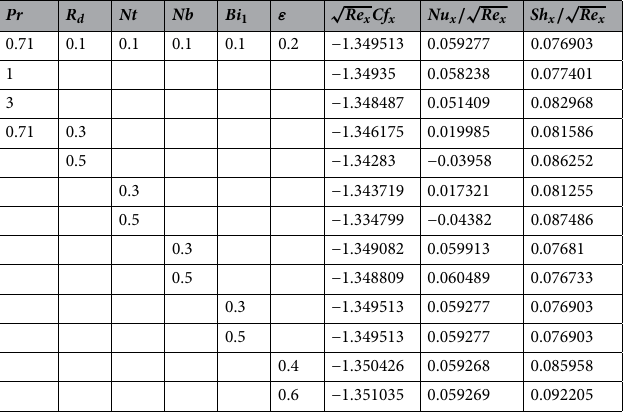
Table 4. The values of √ Re x Cf x , Nu x / √ Re x , and Sh x / √ Re x , for diverse values of Pr , Rd , Nt , Nb , Bi 1 and ε when n = 0.2, β = 0.3, M = 0.2, R d = 0.5, α 1 = 0.1, Le = 0.8, k 1 = 0.1, N = 0.1, (cid:31) = 0.1, Ec = 0.1, E = 2, δ = 0.5, m = 0.5, Bi 2 = 0.1, B r = 0.5, (cid:31) 1 = 2, χ =